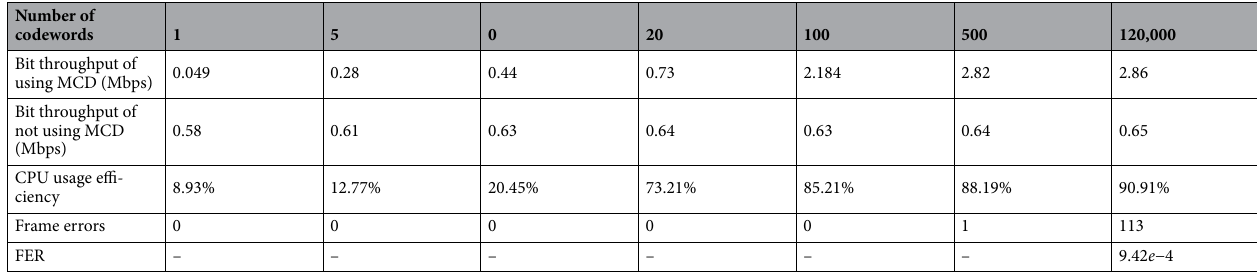
Table 2. By evaluating the 120,000 blocks with ( n , k , t ) = (4095,322,682), the bit throughput of using MCD and the bit throughput of not using MCD are respectively obtained. We also show the CPU efficiency of using MCD and the frame